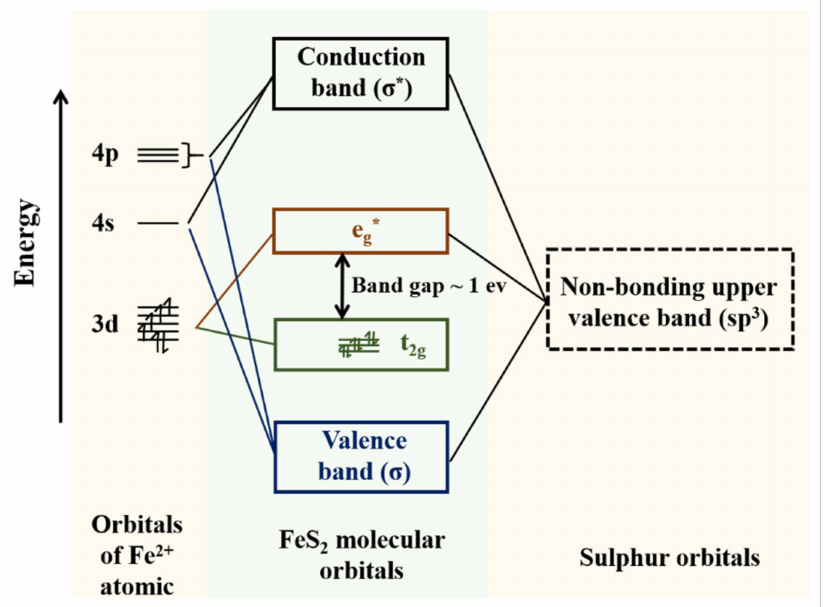
Figure 1. Molecular orbital energy level diagram for